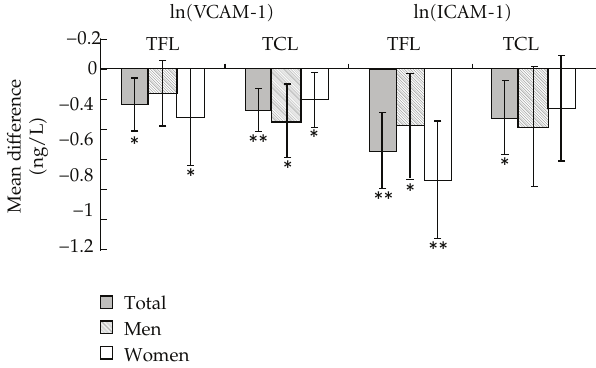
Figure 1: Mean di ff erences of serum intercellular adhesion molecule-1 (ICAM-1) and vascular cell adhesion molecule-1 (VCAM-1) before and after the intervention (ln transformed). Values are means and 95% CIs. ∗ P < 0 . 05, compared with baseline; ∗∗ P < 0 . 01, compared with baseline. ICAM-1, intercellular adhesion molecule-1; VCAM-1, vascular cell adhesion molecule-1; TCL, traditional Chinese liquor; TFL, tea-flavor liquor.